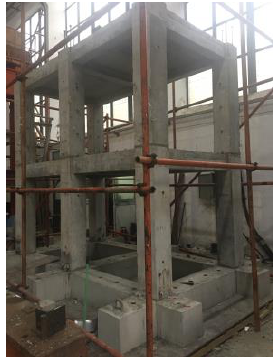
Figure 13. Precast concrete frame structure. Sensors 2020 , 20 , x FOR PEER REVIEW